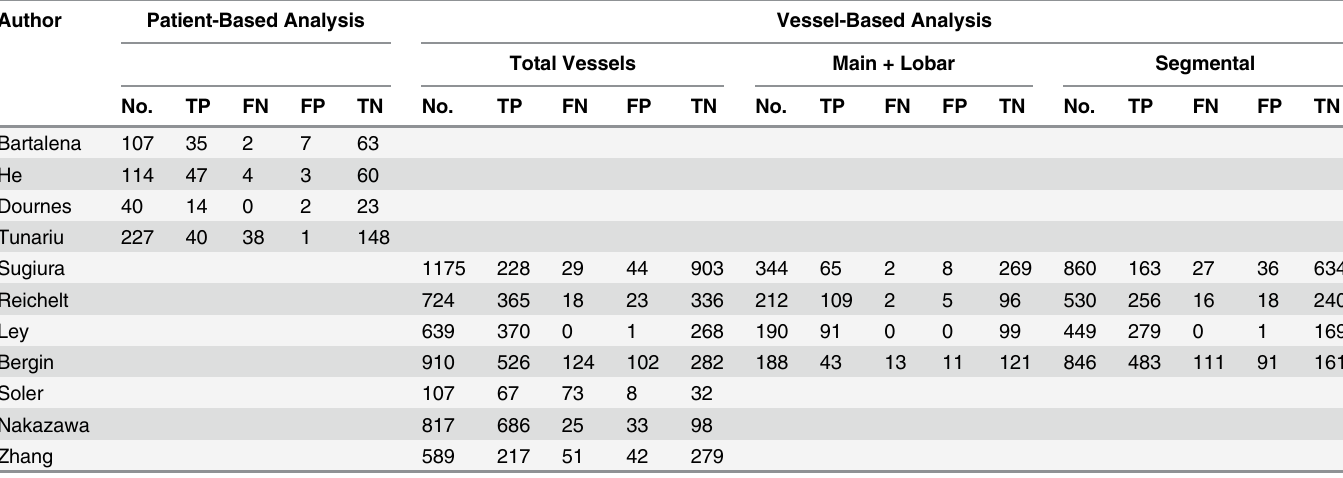
Based on the results from the derived contingency tables, pooled sensitivity, specificity and DOR were calculated. The generated output of sensitivity and 1-specificity were used for the construction of summary receiver operating characteristic (SROC) curves. Also, the area under Table 2. Absolute numbers of included studies 1